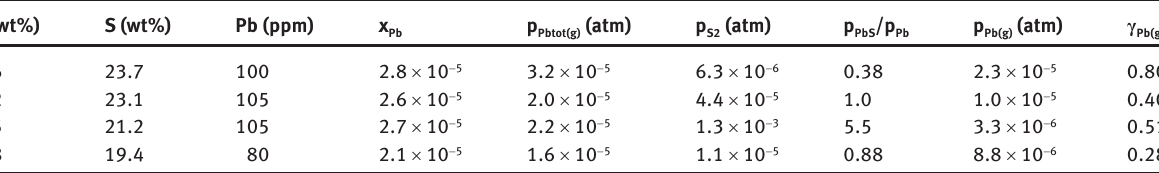
Table 8: Average matte composition, calculated lead mole fraction, sulphur partial pressure and activity coefficient of Pb with respect to Pb(g) for the experiments examining the effect of matte grade where Ar was bubbled into the matte at 100 cm 3 .min − 1